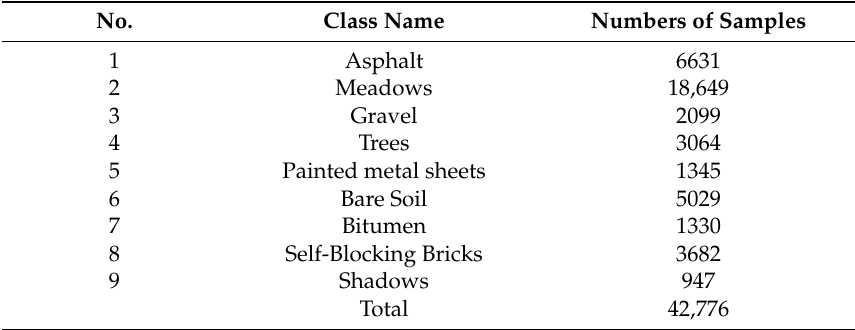
Table 2. Land cover classes and numbers of samples in the Pavia University data set.